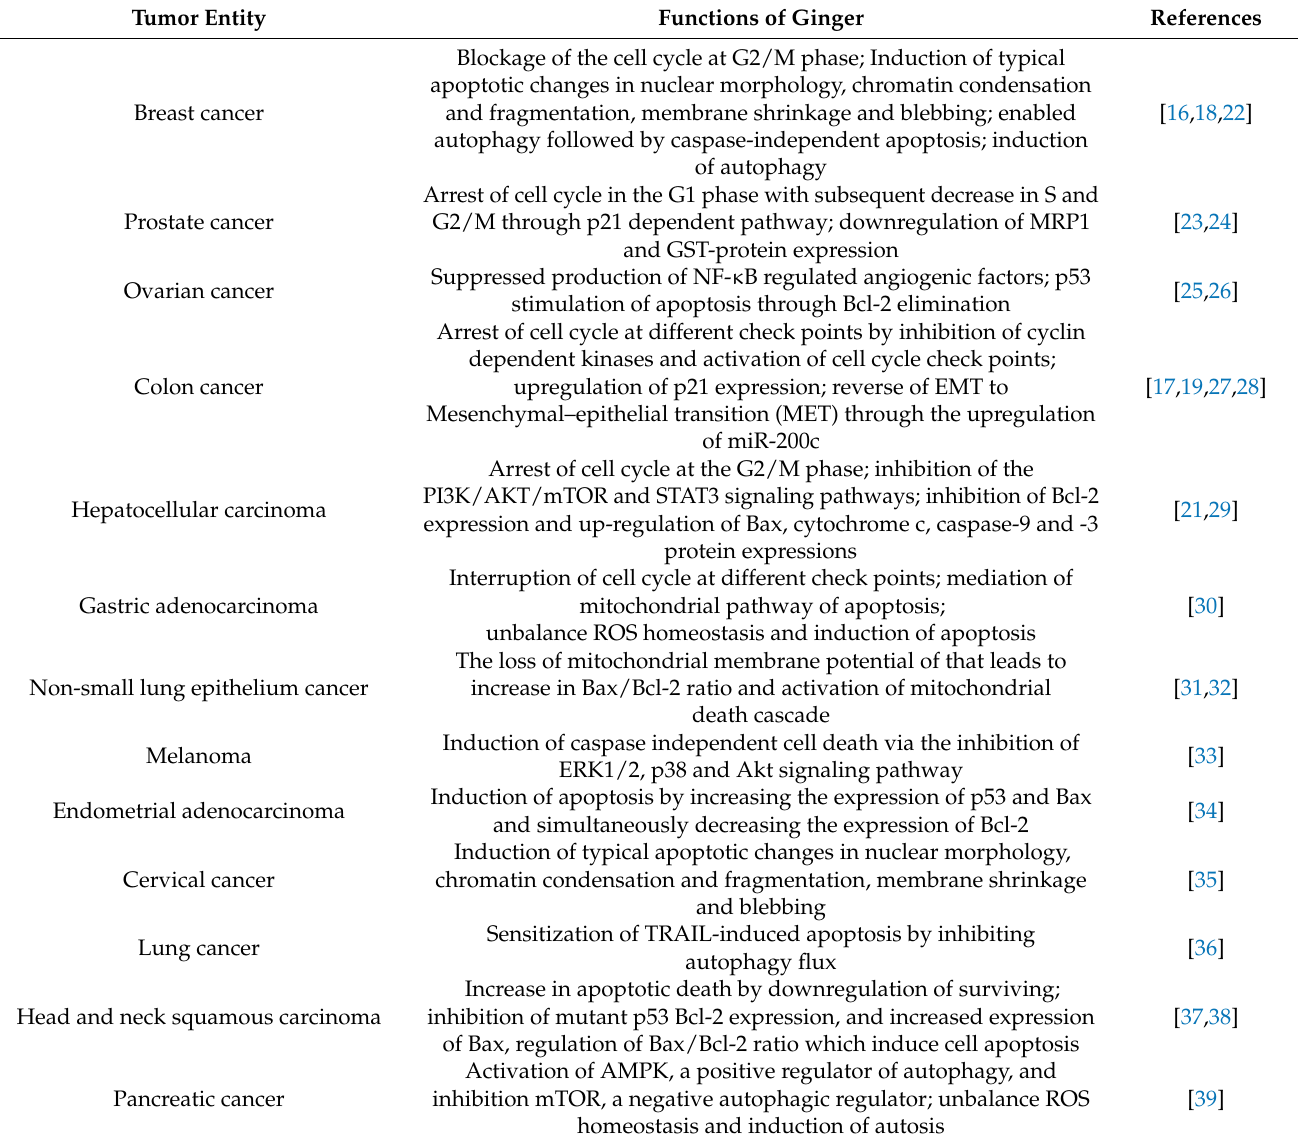
Table 2. Effects of ginger in different types of